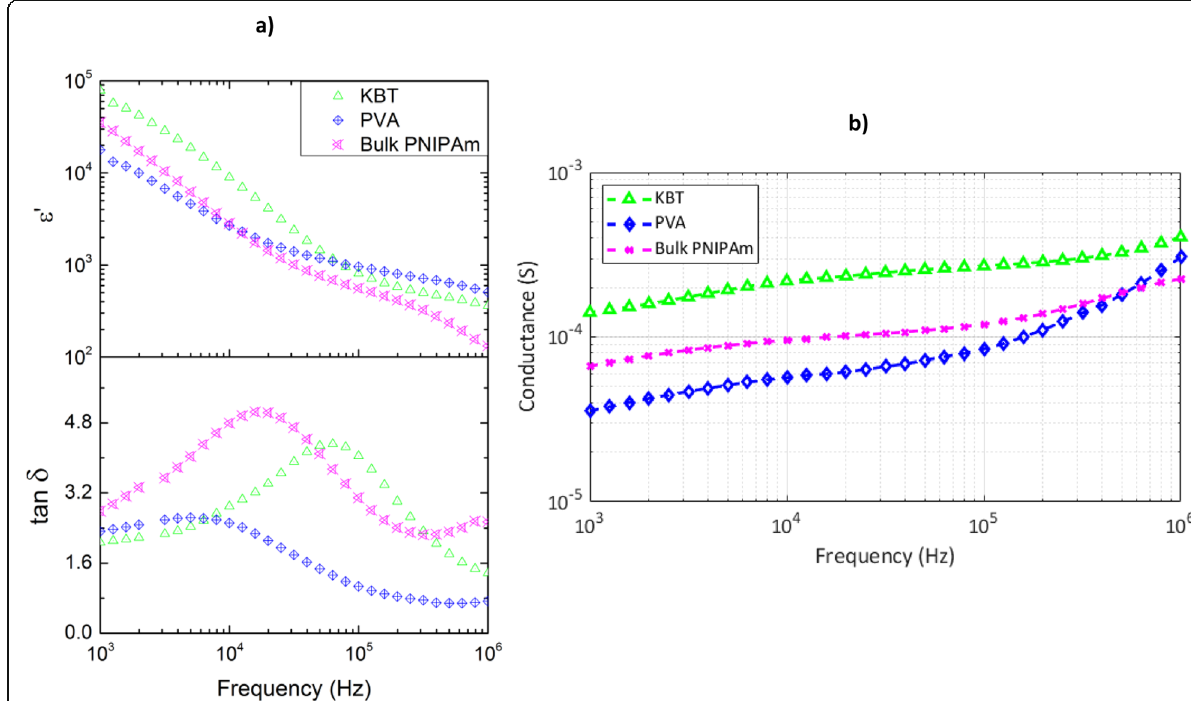
Fig. 4 Direct comparison of PNIPAm, PVA, and KBT composites. a Dielectric constant ( ε ′ ) and loss tangent (tan δ ) of hydrogels in RF frequency range at 27 °C. Characteristics of polarization contributions to the dielectric measurements begin at ~ 100 kHz for KBT800, ~ 20 kHz for PNIPAm, and ~ 10 kHz for PVA. b Conductance of KBT, PVA, and Bulk PNIPAm at 27